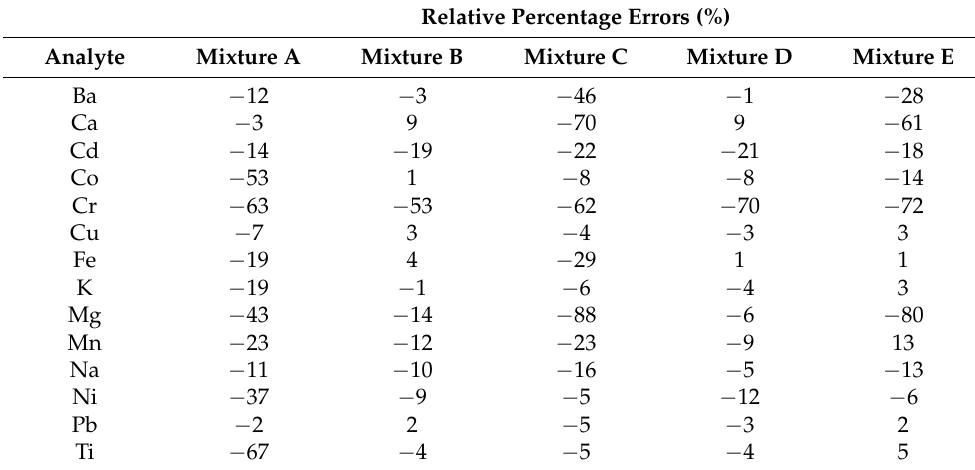
Table 1. Results of optimisation of microwave digestion: relative percentage errors obtained for CRM BCR 176 (“City waste incinerator fly ash”). Relative Percentage Errors